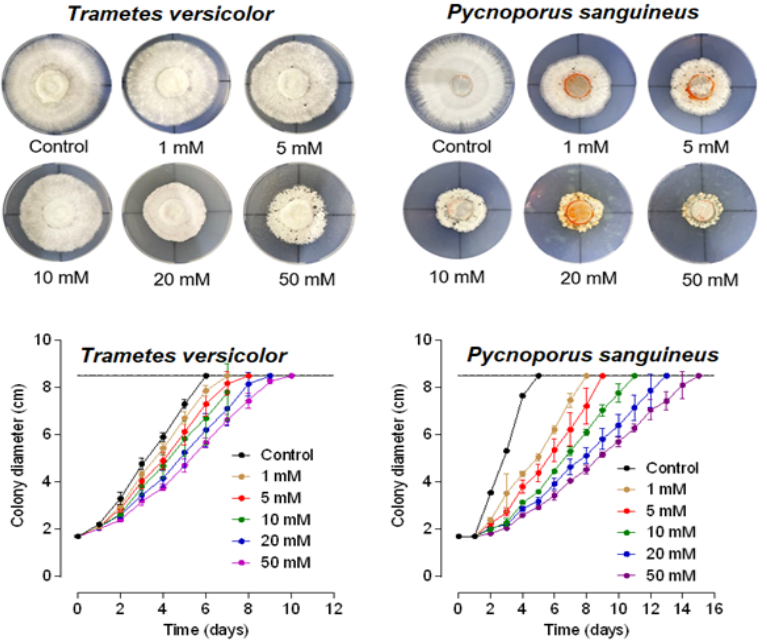
Figure 1. Effect of the farnesol concentration on T. versicolor and P. sanguineus grown in PDA media. Photos were taken on the fifth day of incubation at 28 °C. Control: without farnesol. Effect of farnesol concentration on the average diameter of the colony of T. versicolor and P. sanguineus grown in PDA medium. Petri dish diameter: 8.5 cm (dotted line). Inoculum diameter: 1.7 cm.